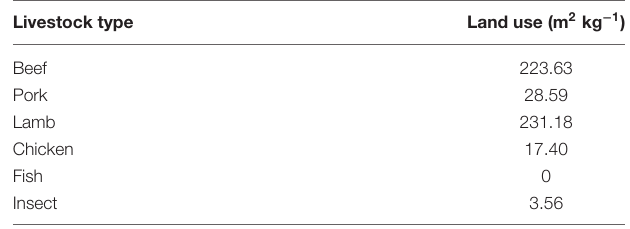
TABLE 3 | Land use required to produce 1kg of each livestock.